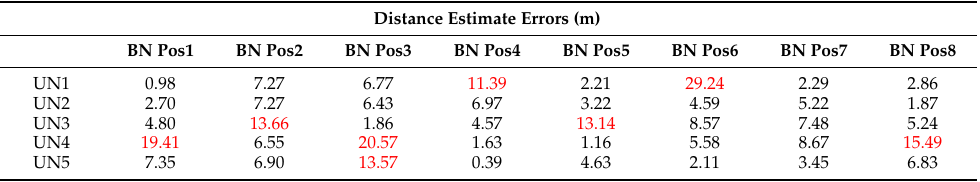
Table 4. Error in estimated distances from the unknown nodes to the beacon node